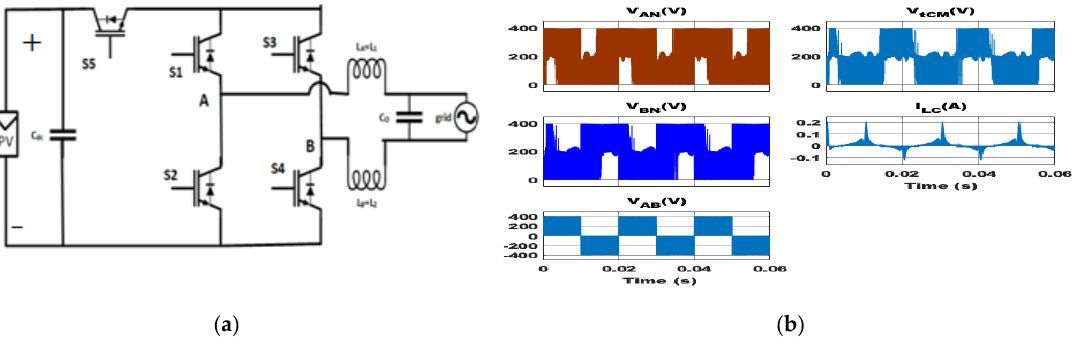
Figure 7. H5 topology: ( a ) circuit structure; ( b ) simulation results.